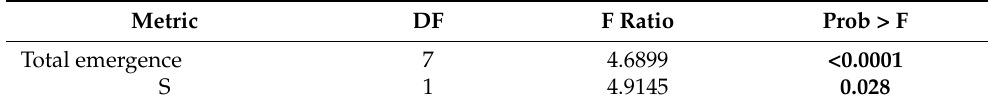
Table 9. Statistical results of a glass house study evaluating the effect of species (S), superabsorbent polymer (SAP) placement depth (D), and their interaction on seedling emergence, shoot and root biomass, shoot:root ratio, time for roots to reach the bottom of the canister (Time), and root length at 3 weeks. Mean comparisons were also made orthogonally evaluating species (S), SAP presence or absence (P), and the interaction of the two. Bolded numbers indicate p < 0.05. Metric DF F Ratio Prob > F Total